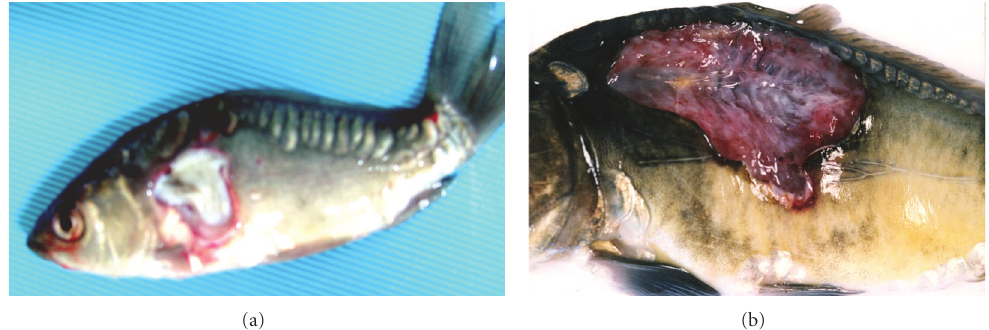
Figure 1: Ulcers in carps Sc challenged with A. hydrophila strain Pt39 (a) and A. bestiarum strain J4N (b). Very deep ulcer exposing skeleton after injection of A. bestiarum .